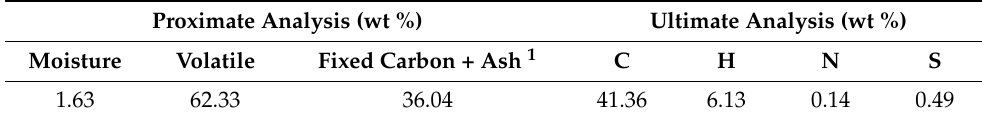
Table 2. Proximate and ultimate analyses of the dried cold-rolling sludge.